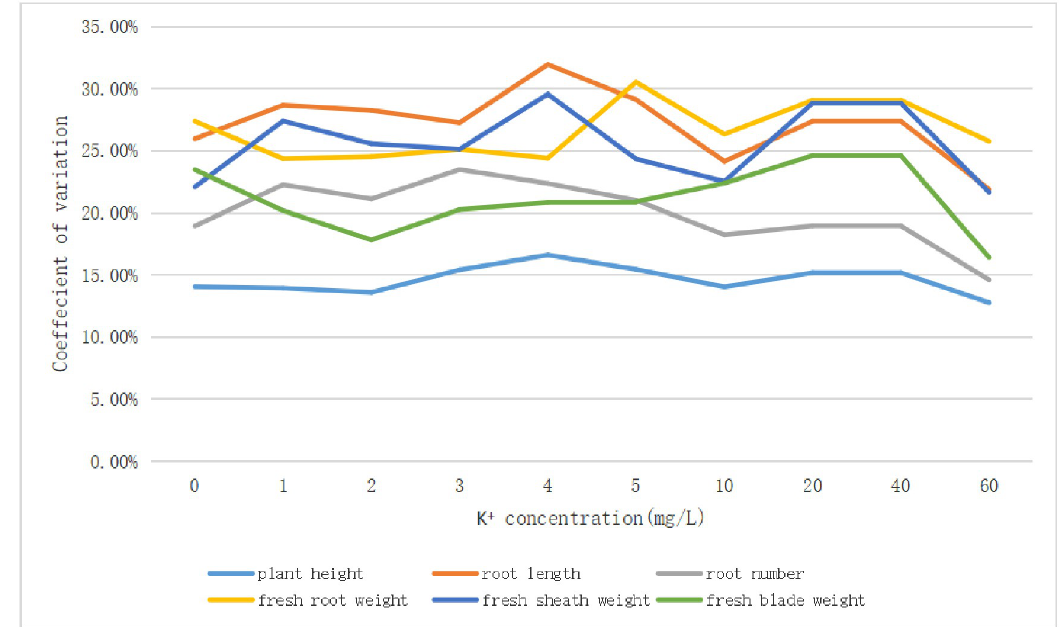
Fig 4. The variation coefficient of parameters of twelve rice varieties treated with different potassium concentration medium. The dotted line is japonica rice and the solid line is indica rice.